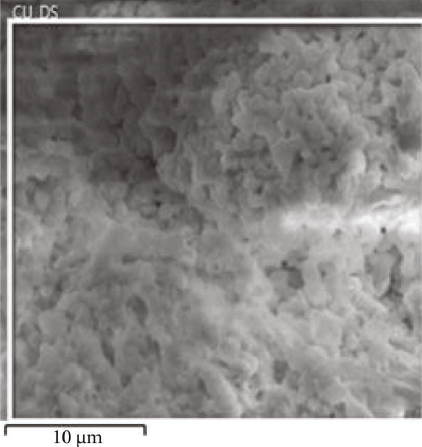
Figure 7: SEM image of [Cu( L